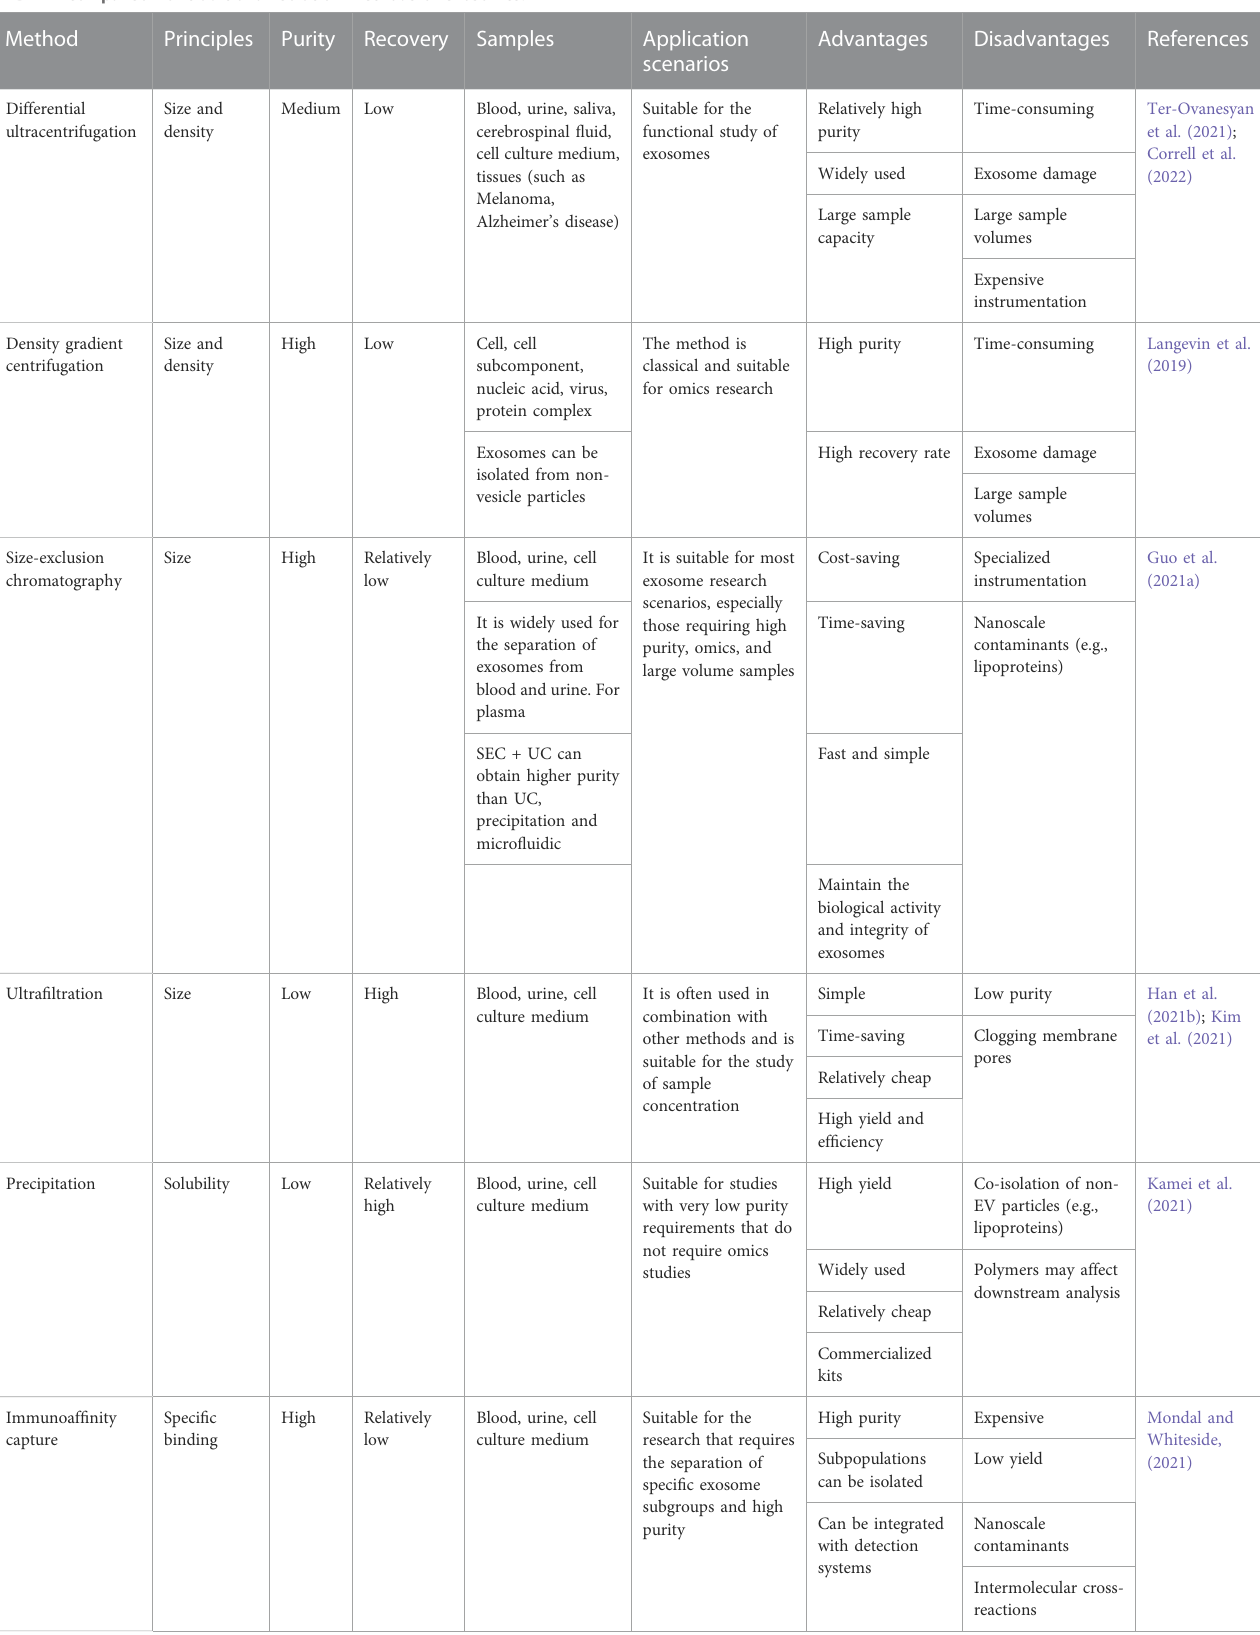
TABLE 1 Comparison of traditional isolation methods of